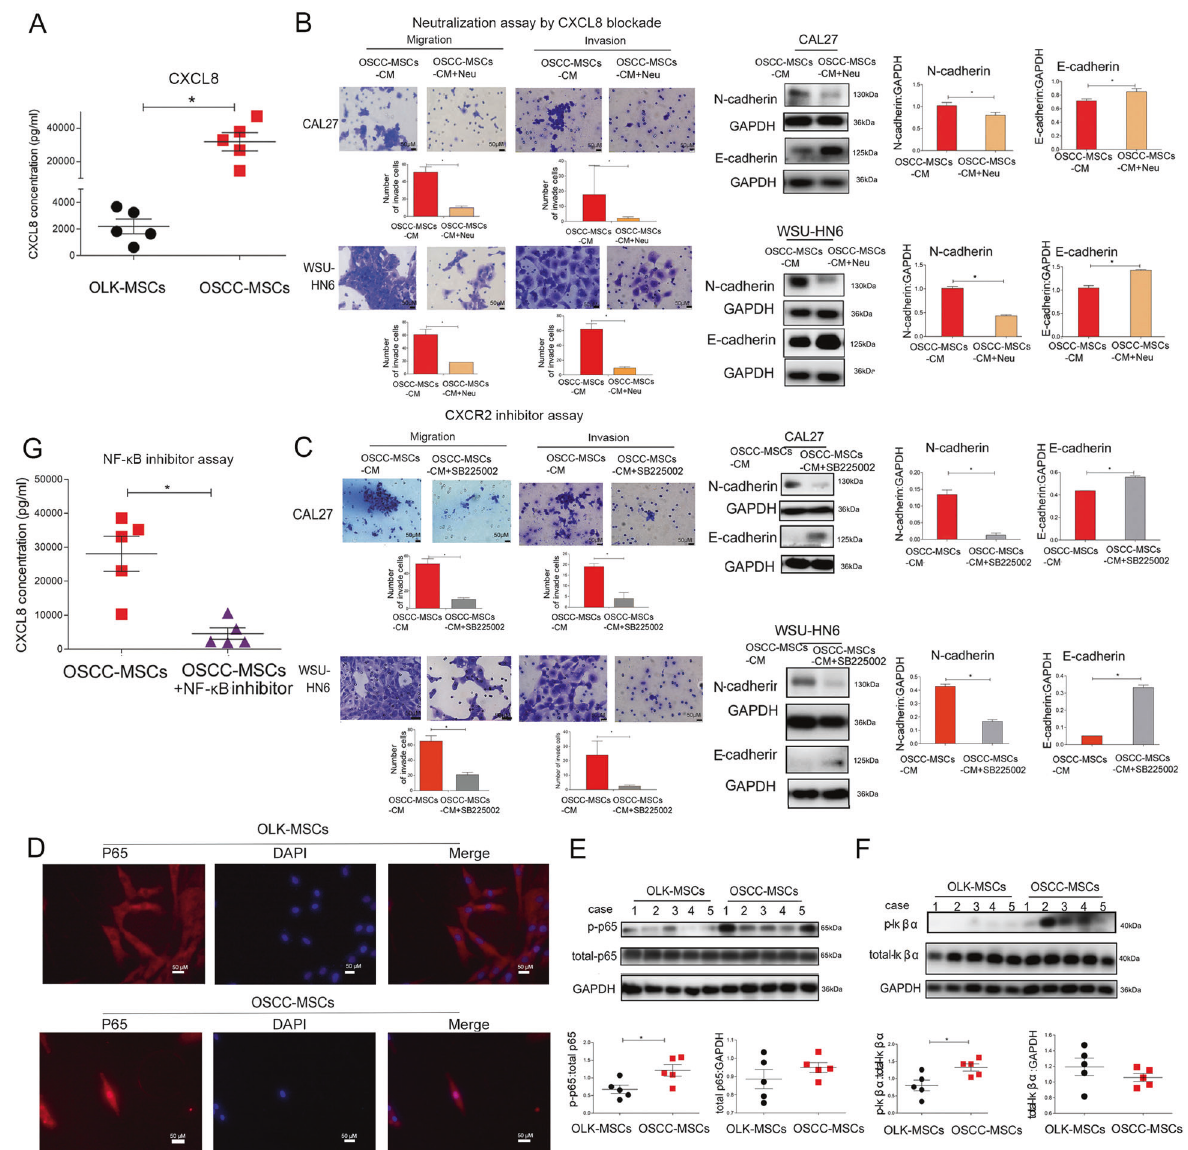
Fig. 3 Overexpression CXCL8 secretion regulated by NF- κ B pathway in OSCC-MSCs. A The level of secreted CXCL8 was observed in the conditioned medium of OLK-MSCs and OSCC-MSCs ( n = 5). Neutralizing antibody (CXCL8) ( B ) and CXCR2 inhibitor (SB225002) ( C ) inhibited OSCC-CM-induced OSCC cell line metastasis through EMT -related proteins. D Representative immuno fl uorescence images of the translocation of p65 in OLK-MSCs and OSCC-MSCs. Scale bars = 50 µm. Western blotting was used to measure the differential expression of p65 ( E ) and I κ B α ( F ) (NF- κ B pathway) in OLK-MSCs ( n = 5) and OSCC-MSCs ( n = 5). G The NF- κ B inhibitor suppressed the secretion of CXCL8 by Elisa. The tests were repeated three times. Data were expressed as means ± SD. * p <